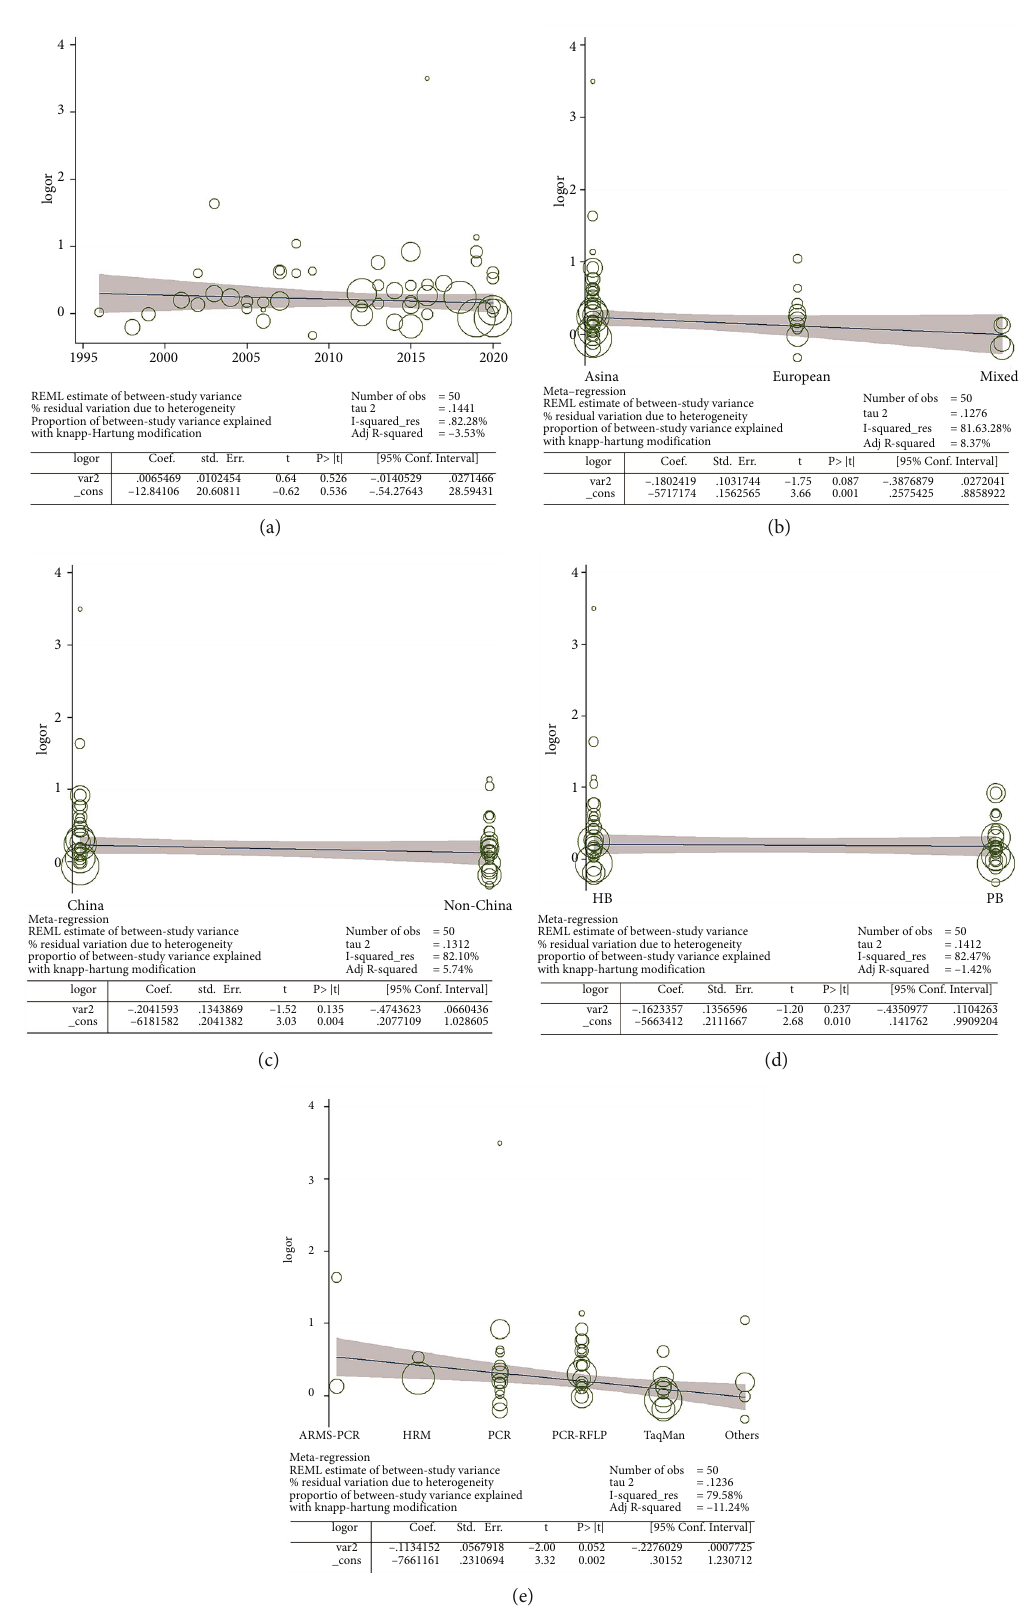
Figure 10: Random-e ff ect metaregression of log odds ratio versus publication year (a), regular ethnicity (b), Chinese/non-Chinese (c), source of control (d), and genotype methods (e), respectively, in